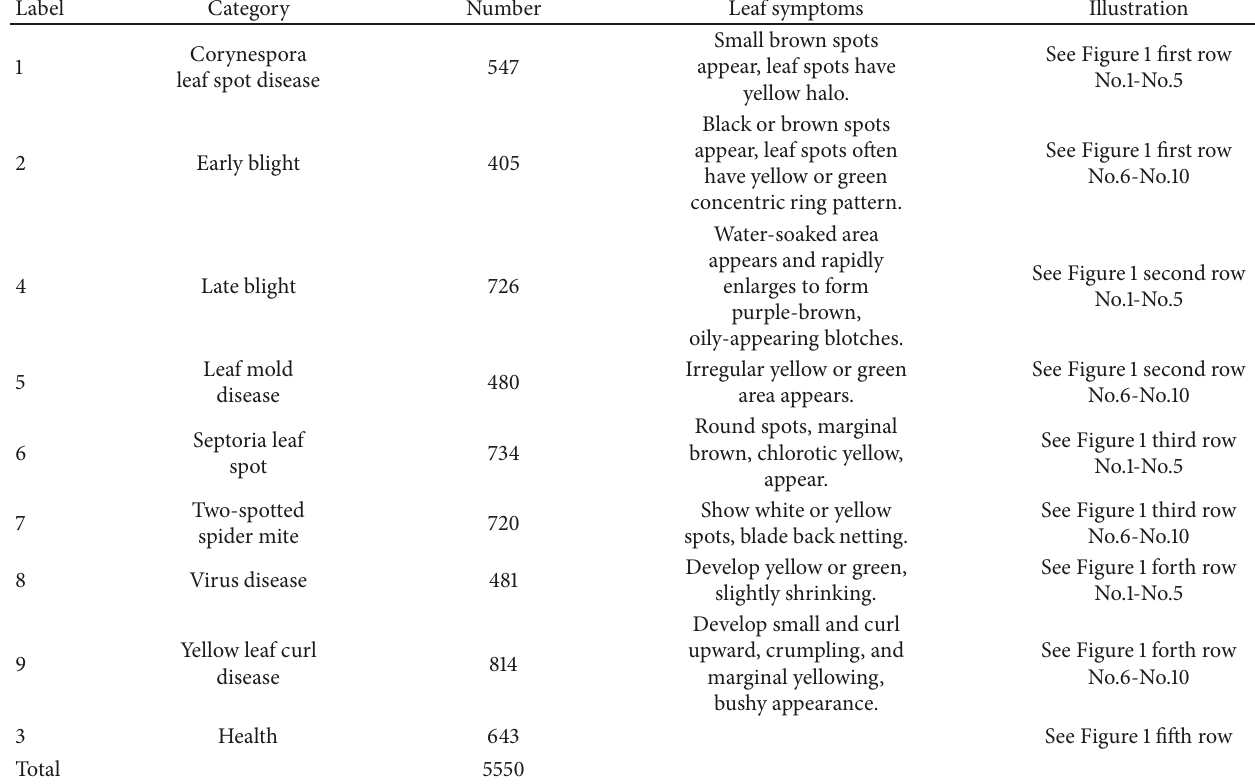
Table 1: The raw tomato leaf